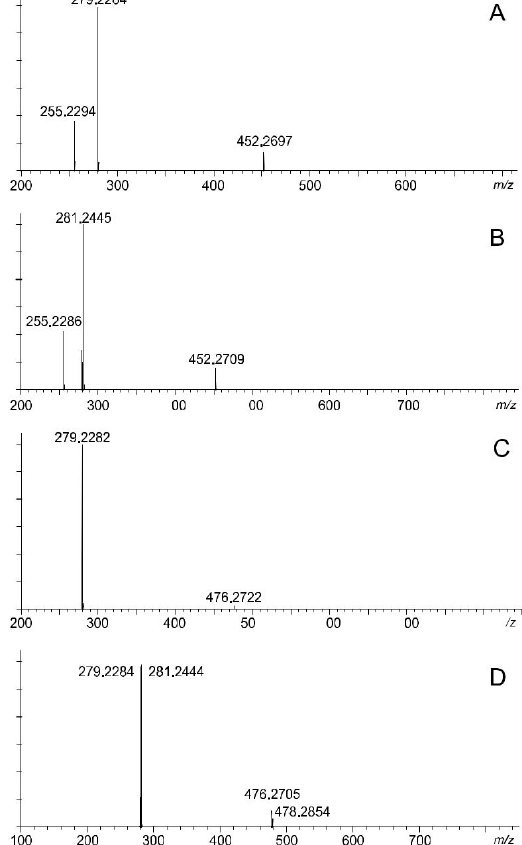
Figure 2. The high-resolution mass spectrometry (HRMS) spectra of ( A ) negative quasi-molecular ions [M-H] − and ( B ) positive cluster ions [M+H + (C 2 H 5 ) 3 N] + of phosphatidylethanolamine (PE) molecular species, MS 2 spectra of negative quasi-molecular ions [M − H] − at m/z 714.4988 ( A ), 716.5163 ( B ), 738.4975 ( C ), and 740.5140 ( D ) corresponded to 16:0/18:2 PE, 16:0/18:1 PE, 18:2/18:2 PE, and 18:1/18:2 PE molecular species of phosphatidylethanolamine MS 2 spectra of negative quasi-molecular